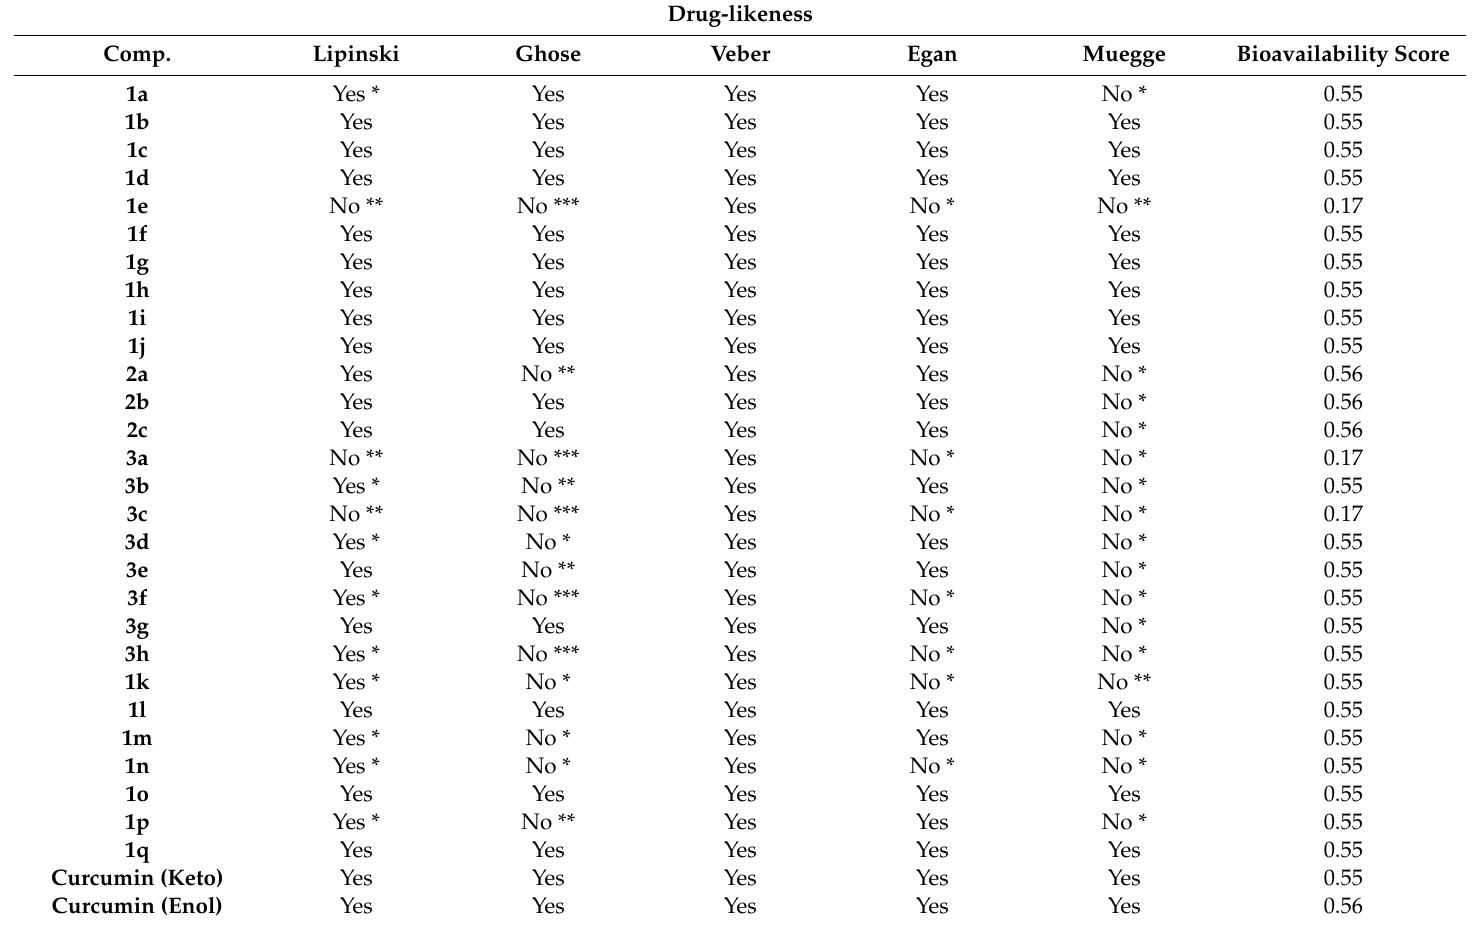
Table 5. Multiple estimations of